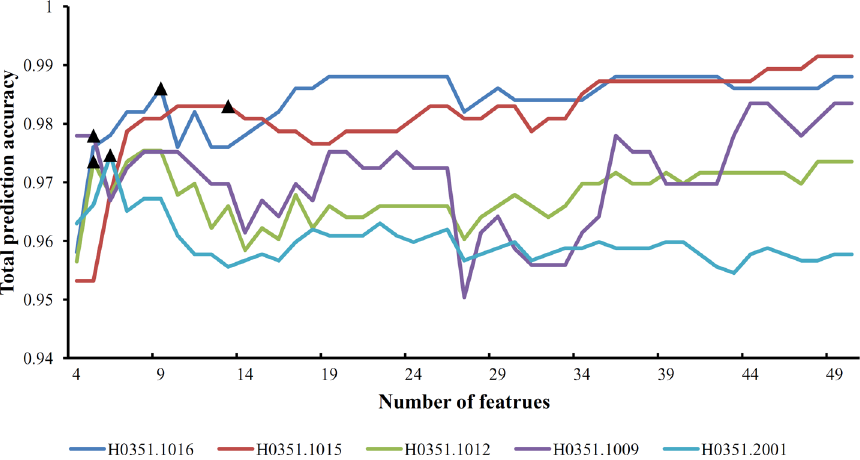
Fig 7. Parts of five IFS-curves using the data of H0351.2002 as the training dataset and the data from other people as the test dataset. The triangle in each curve represents the inflection